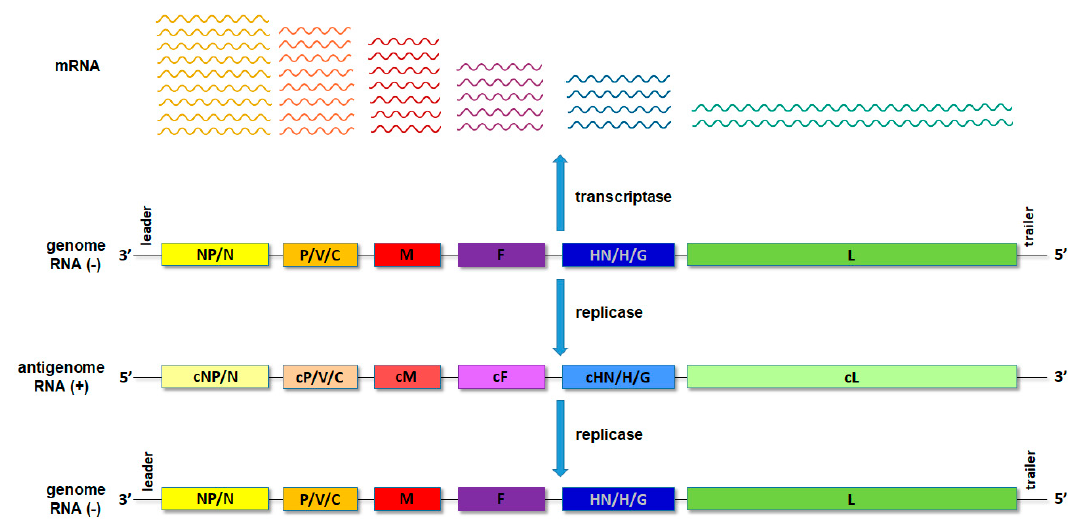
Figure 2. Schematic presentation of the transcription and translation processes with the RNA abundance gradient.